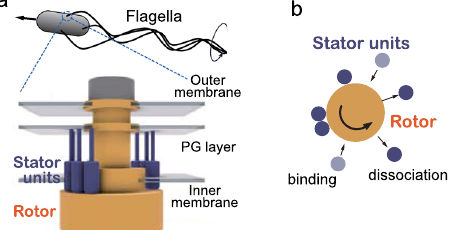
Fig. 1 Bacterial fl agellar motor. a The bacterial fl agellar motor is a supramolecular complex with a diameter of about 45 nm spanning the membrane 1 – 4 . The motor consists of a rotor (yellow) and multiple torque- generating stator units (blue). The stator units have ion channels and generate torque at the interface with the rotor by exploiting the free energy change liberated by the ion currents through the channels. The stator units interact with the rotor at its bottom part and are anchored to the rigid peptidoglycan (PG) layer with its top part 25 – 27 . b The stator units bind to and dissociate from the motor.